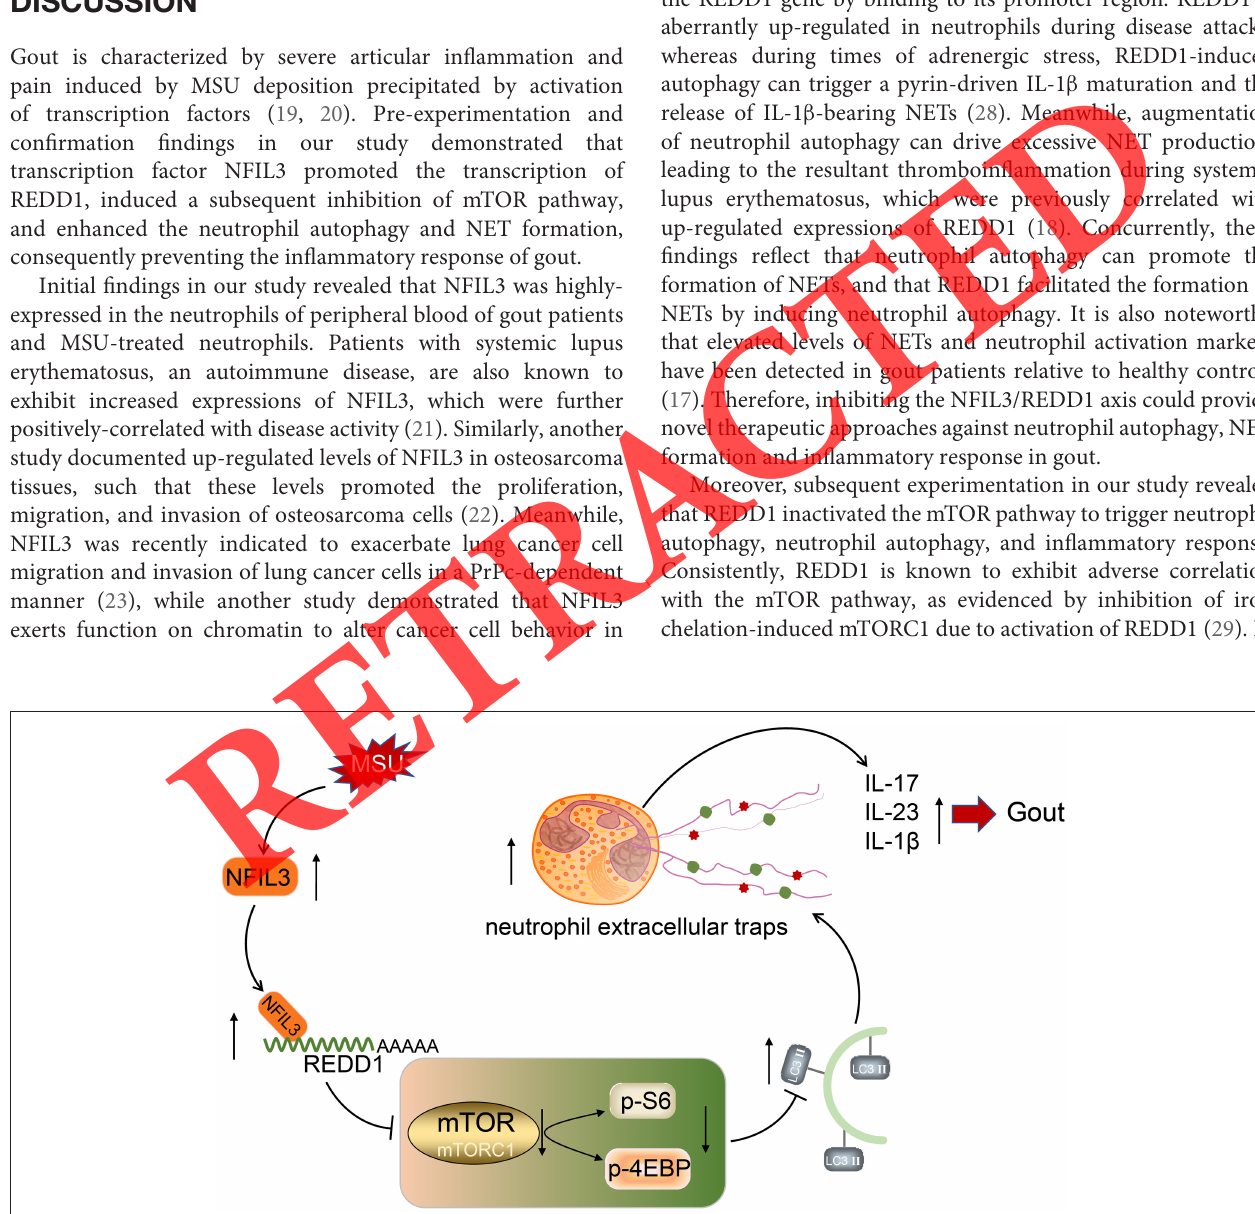
FIGURE 7 | Schematic diagram of the mechanism by which NFIL3 affects gout. NFIL3 promotes the transcription of REDD1 and inhibits the mTOR pathway, thus activating the autophagy of neutrophils and inducing the formation of NETs, eventually aggravating the inflammatory response of gout.